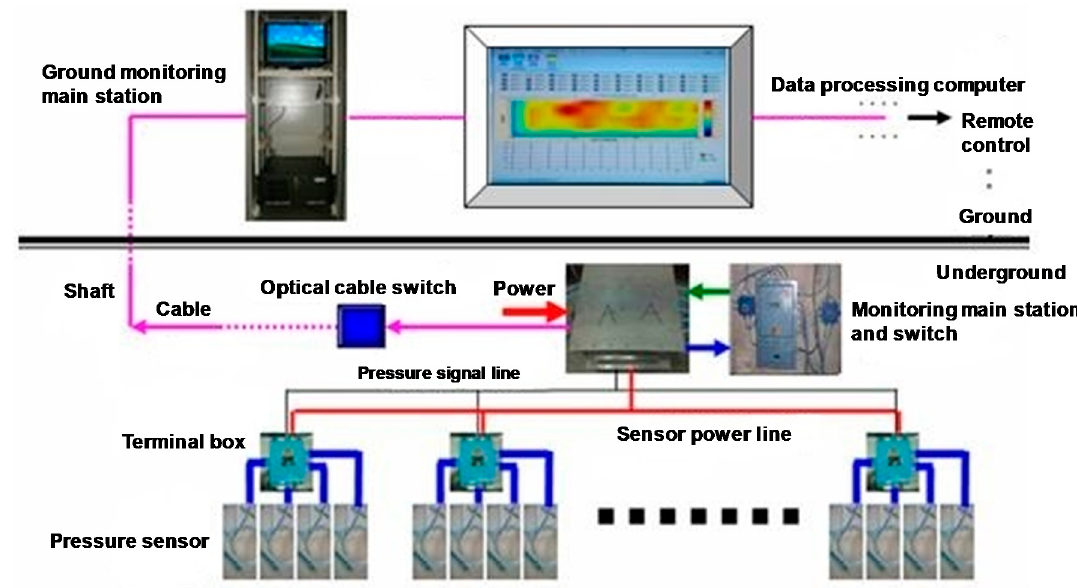
Figure 15. Schematic diagram of remote monitoring system.